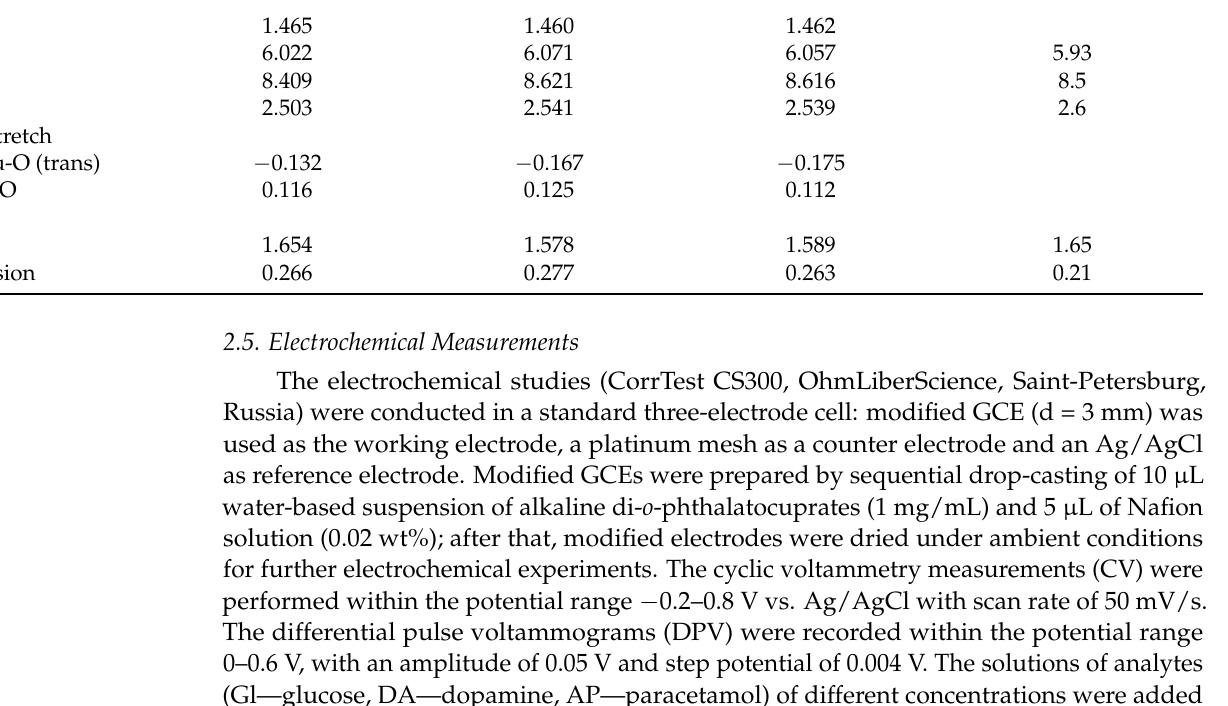
Table 4. Refined force constants for I – III . Stretching force constants are given. 10 2 N m − 1 , bending—10 − 18 N m. Force